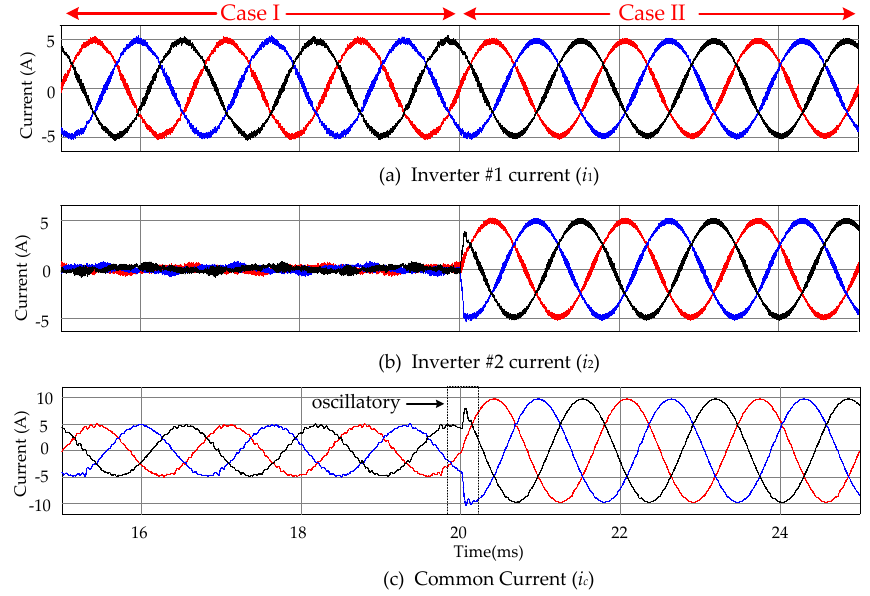
Figure 9. Simulation results for Cases I and II under the conventional scheme presented in [7].